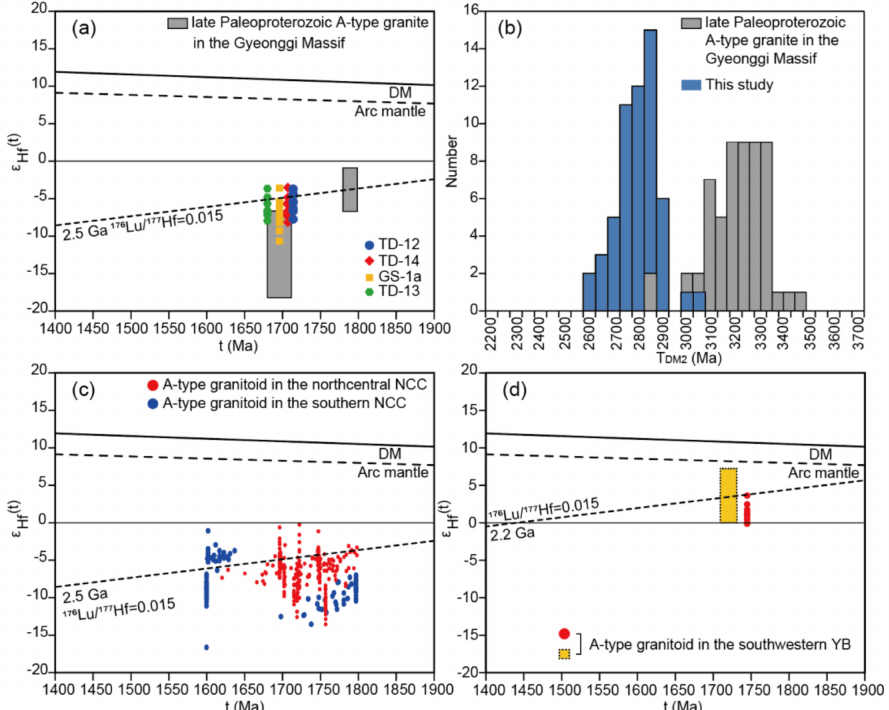
Figure 8. ( a ) ε Hf(t) versus crystallization ages for the Statherian granitoids in the southwestern part of the Korean Peninsula and the Gyeonggi Massif (data collected from this study and [9]). The extrapolation of the depleted and arc mantle was made from the values suggested by [37,38]. ( b ) Histogram of zircon model ages (data collected from this study and [9]). ( c ) ε Hf (t) versus crystallization ages for the Statherian granitoids in the eastern NCC (data collected from [8,10,11], and references therein). ( d ) ε Hf (t) versus crystallization ages for the Statherian granitoids in the southwestern part of the Yangtze Block (data collected from